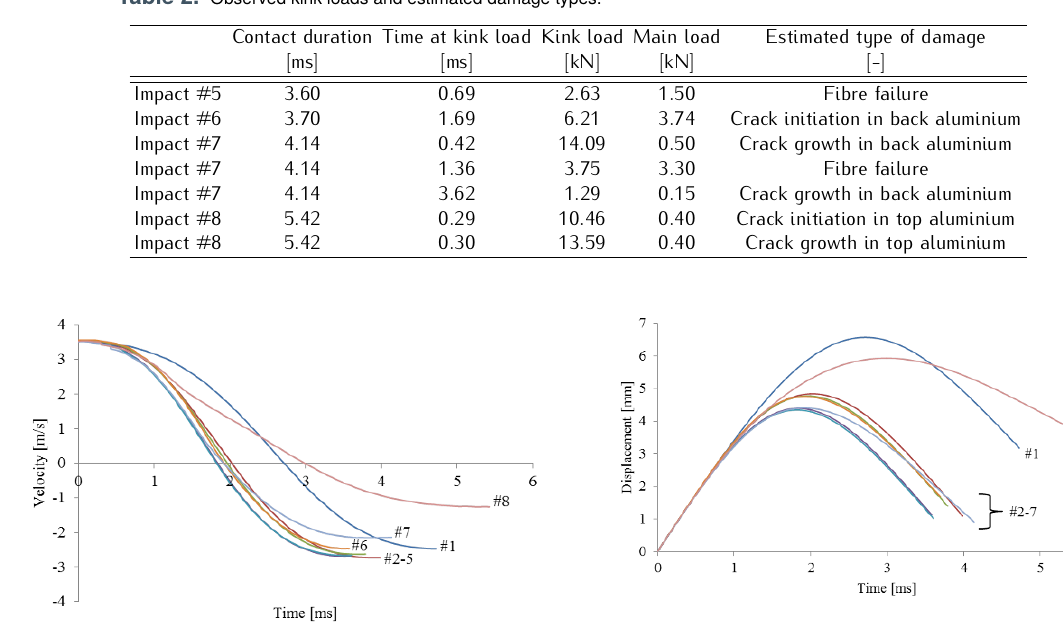
are highlighted [20, 21]. If time at maximum force equals half of contact duration, the impact is purely elastic. If time